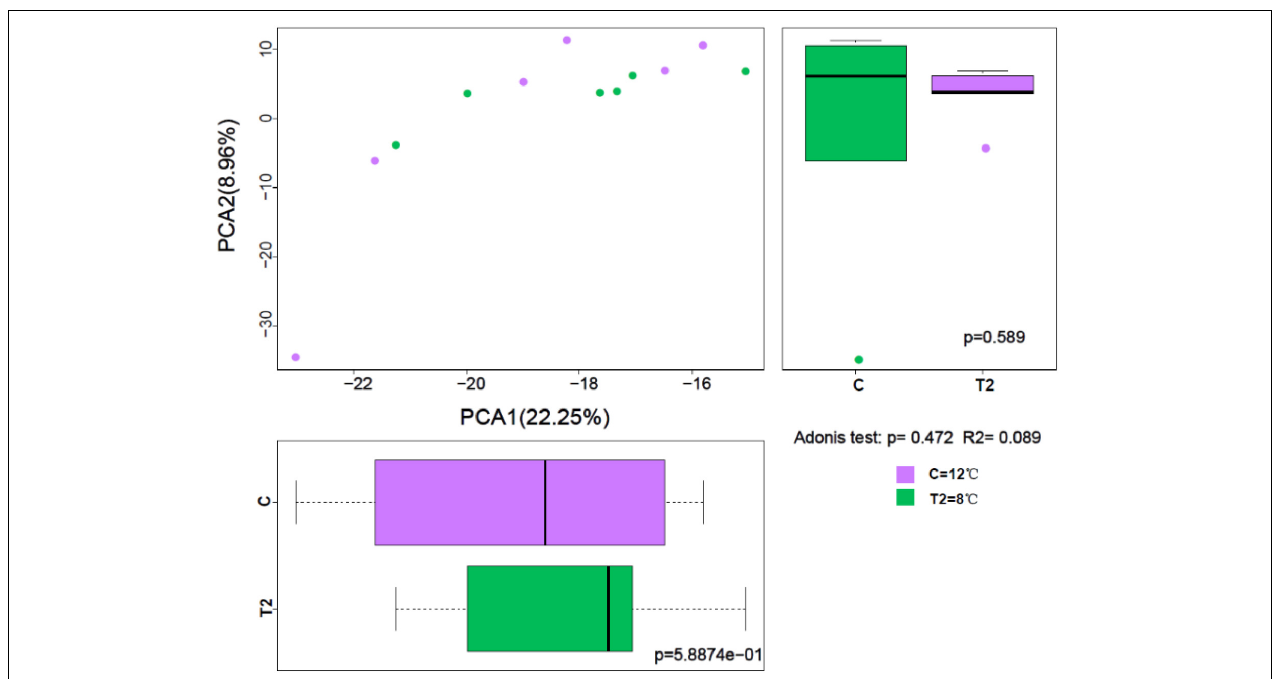
FIGURE 6 | Adonis test of intestinal microbiota samples of large yellow croaker. C represents the control group where the fish were kept at 12 ◦ C since the beginning of the experiment and T2 represents the group where the fish were kept at 8 ◦ C for 3 days.